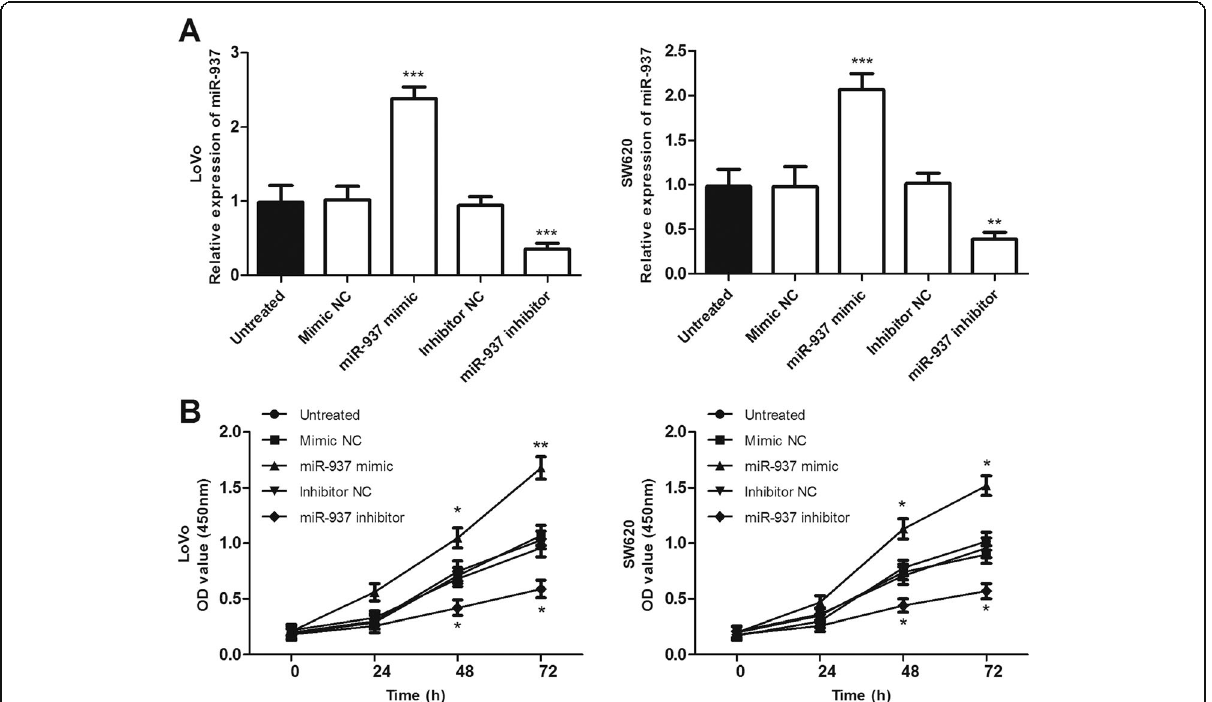
Fig. 3 Overexpression and downregulation of miR-937 promotes and inhibits the proliferation of colon cancer cells (LoVo and SW620), respectively, compared with untreated cells. a . The relative expression level of miR-937 was significantly increased by miR-937 mimic, while decreased by miR-937 inhibitor in LoVo and SW620 cells, compared with that in the untreated cell. b . Cell proliferation was detected by CCK-8 assay. * P < 0.05, ** P < 0.01, *** P <